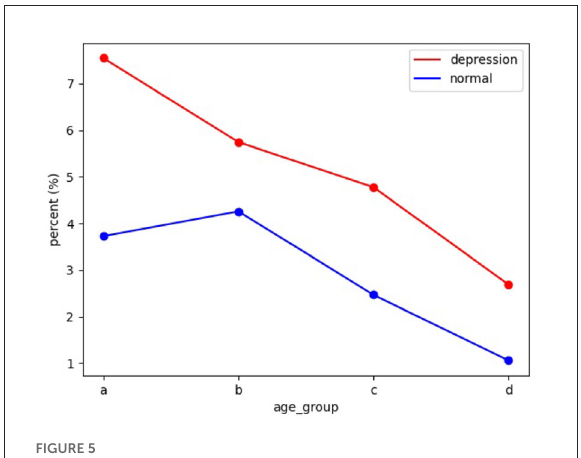
FIGURE5 This figure shows the change in the number of tweets with cognitive distortions on social media platforms with age. The horizontal axis is the group, and the vertical axis is the percentage of total cognitively distorted